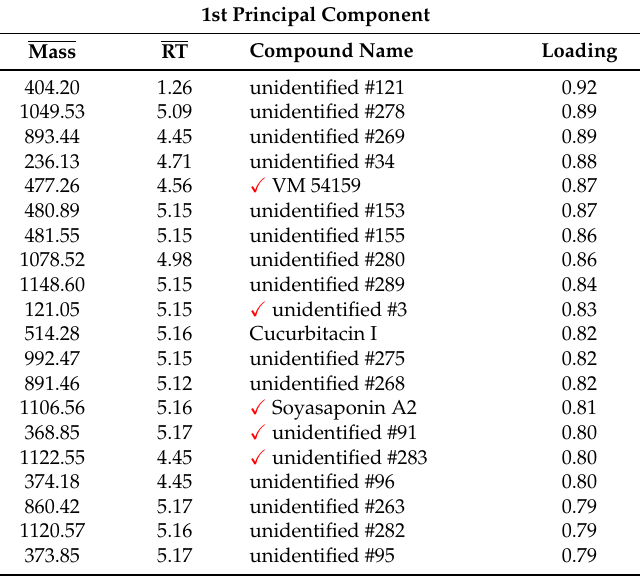
Figure S1: Biological replicate reproducibility, Table S1: Metabolite univariate differences, Table S2: Summary of metabolite